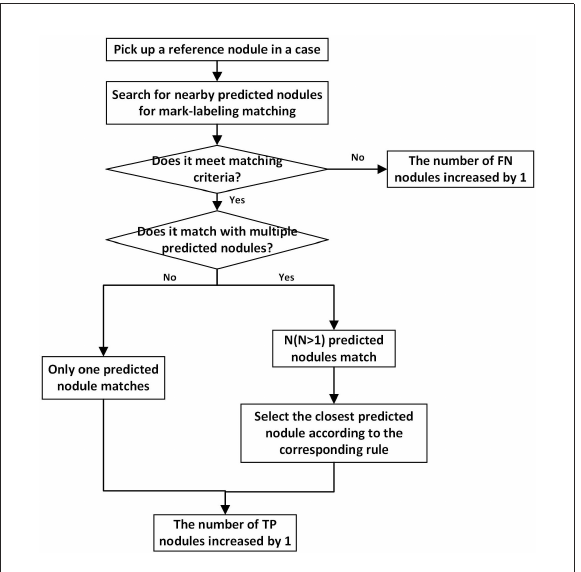
FIGURE2 The flowchart depicting matching process for one reference nodule. Every reference nodule in each case goes through matching process. Unmatched predicted nodules result in a corresponding increase in the number of FPs